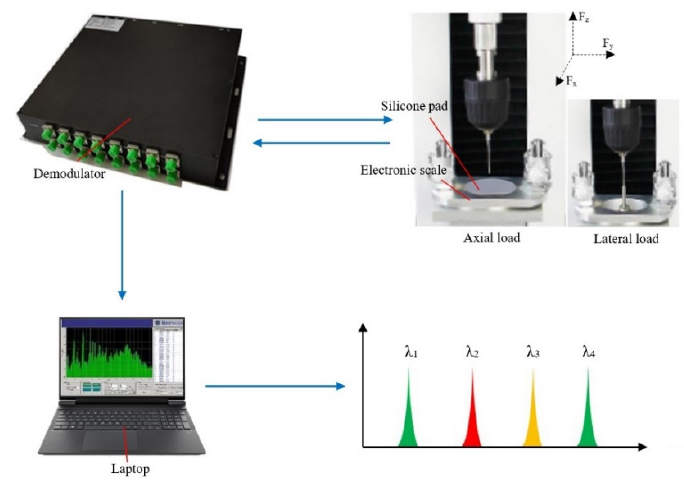
Figure 8. The sensor calibration platform.